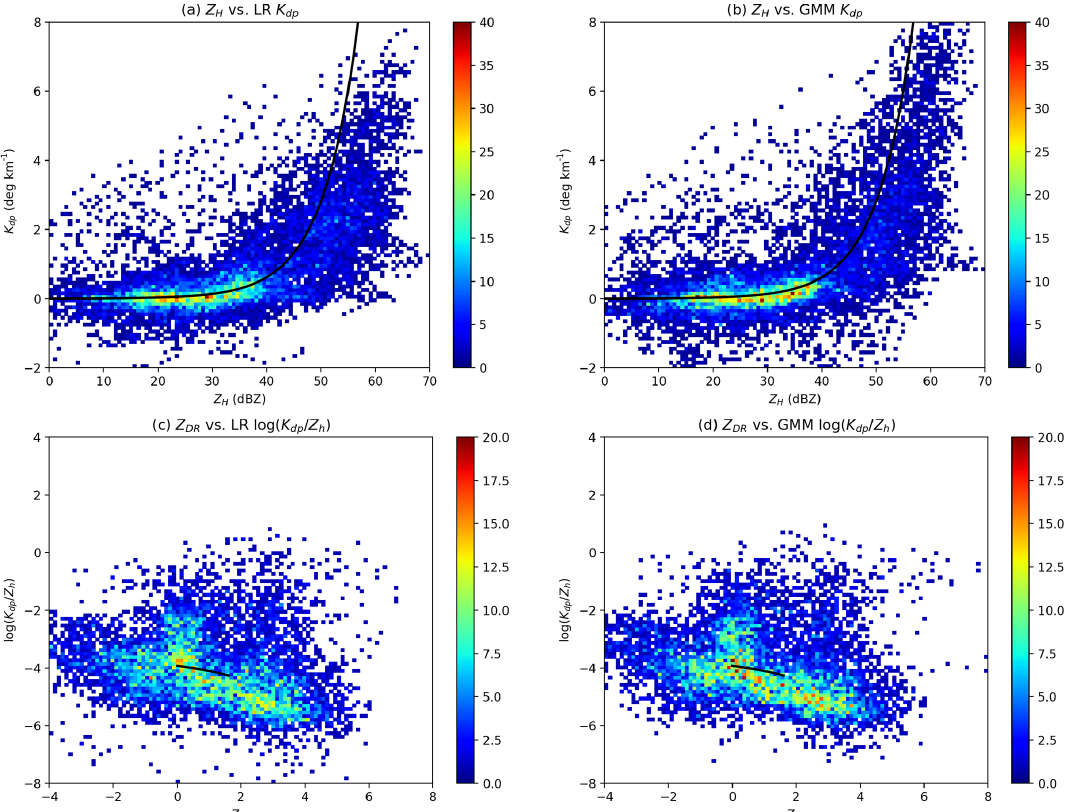
Figure 10. Comparison with the self-consistency relations: (a) Z H vs. LR K dp , (b) Z H vs. GMM K dp , (c) Z DR vs. the ratio of LR K dp and Z h , and (d) Z DR vs. the ratio of GMM K dp and Z h , where Z H = 10log (Z h ) . The color scale is the number of points, and the black curves are the theoretical self-consistency